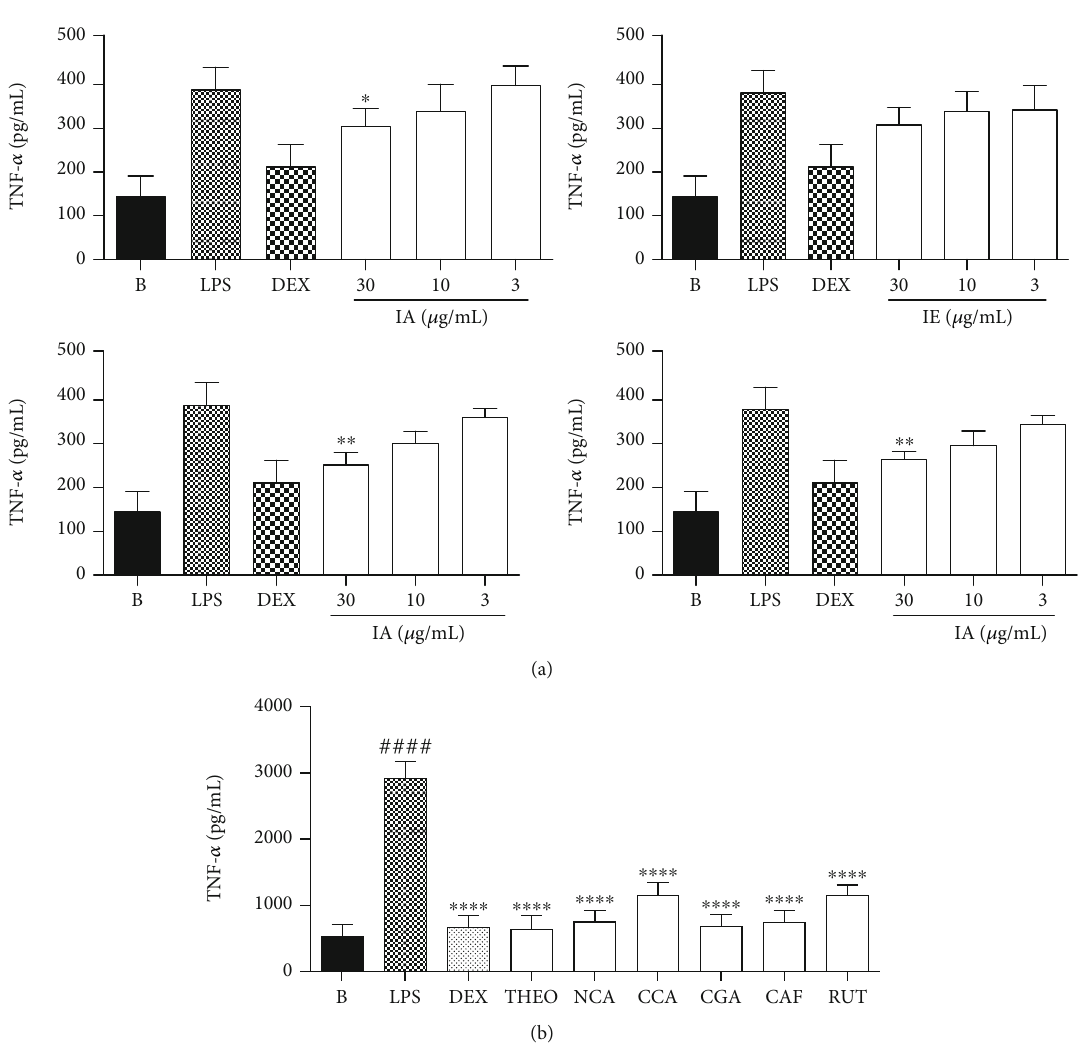
Figure 8: E ff ects of chemical marker compounds on TNF- α secretion levels in LPS-treated RAW 264.7 macrophages. B: untreated cells; LPS: cells treated with only lipopolysaccharide (1 μ g/mL); DEX: cells pretreated with dexamethasone (7 μ M) before LPS administration. Results were expressed as mean ± SEM ; n = 3 . (a) Extracts: ∗ p < 0 : 05 vs. group B or ∗∗ p < 0 : 005 . IA: aqueous infusion; IE: ethanolic infusion; TA: aqueous turboextraction; TE: ethanolic turboextraction. (b) Compounds: #### p < 0 : 0001 vs. group LPS; ∗∗∗∗ p < 0 : 01 vs. group B. THEO: theobromine; NCA: neochlorogenic acid; CCA: cryptochlorogenic acid; CGA: chlorogenic acid; CAF: ca ff eine; RUT: